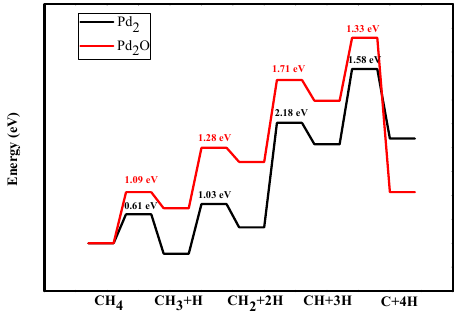
Figure 6. Energy profiles of dehydrogenation from CH 4 to C: CH 4 → CH 3 + H → CH 2 + 2H → CH + 3H → C + 4H on Pd 2 and Pd 2 O. Black line and red line represent the dissociation of CH x on Pd 2 and Pd 2 O.